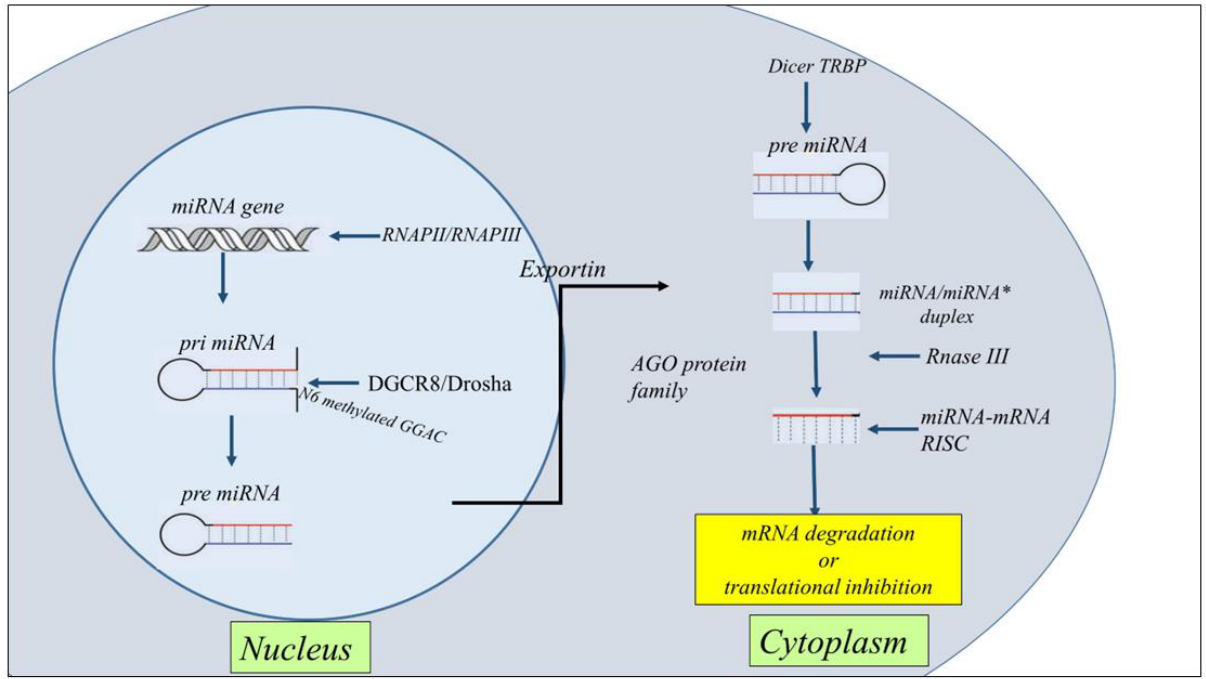
Figure 2. Schematic representation of the general steps of miRNA biogenesis. The biogenesis of miRNAs starts in the nucleus with the processing of RNA polymerase II/III transcripts post- or co-transcriptionally into pri-miRNAs. Then, a ribonuclease III enzyme transforms the pri-miRNAs in pre-miRNAs, which are transported into the cytoplasm by Exportin 5 (XPO5)/RanGTP complex action. Reaching the cytoplasm pre-miRNA is transformed in mature miRNA/miRNA* duplex by RNase III endonuclease Dicer and the RNA-binding protein TRBP the action. miRNA then forms a miRNA-mRNA RISC complex to induce mRNA degradation or translational repression.